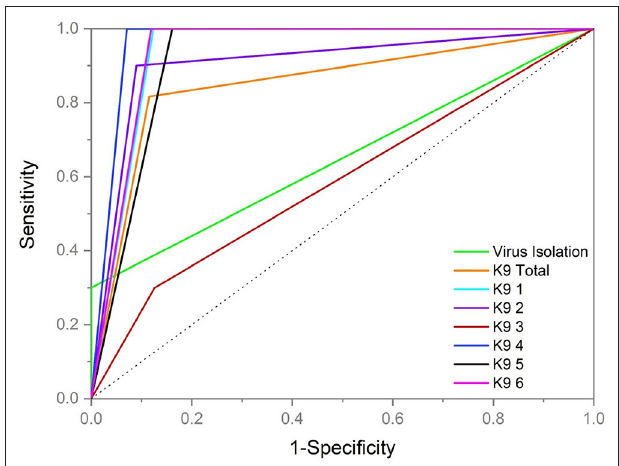
FIGURE 4 | Graph of Receiver Operator Characteristic (ROC) curve representing all dogs ( n = 6) as a test modality (K9 Total), each individual dog (K9 1, K9 2, K9 3, K9 4, K9 5, and K9 6) and virus isolation monitoring. K9 results represent blood sample testing during peak infective window samples of positive day + 6 through + 10 and corresponding trial control samples examined by the dogs. Virus isolation results represent all blood samples for virus isolation testing during peak infective window samples of positive day + 6 through + 10 and control samples. The dotted reference line runs through the center representing a diagnostic performance no better than